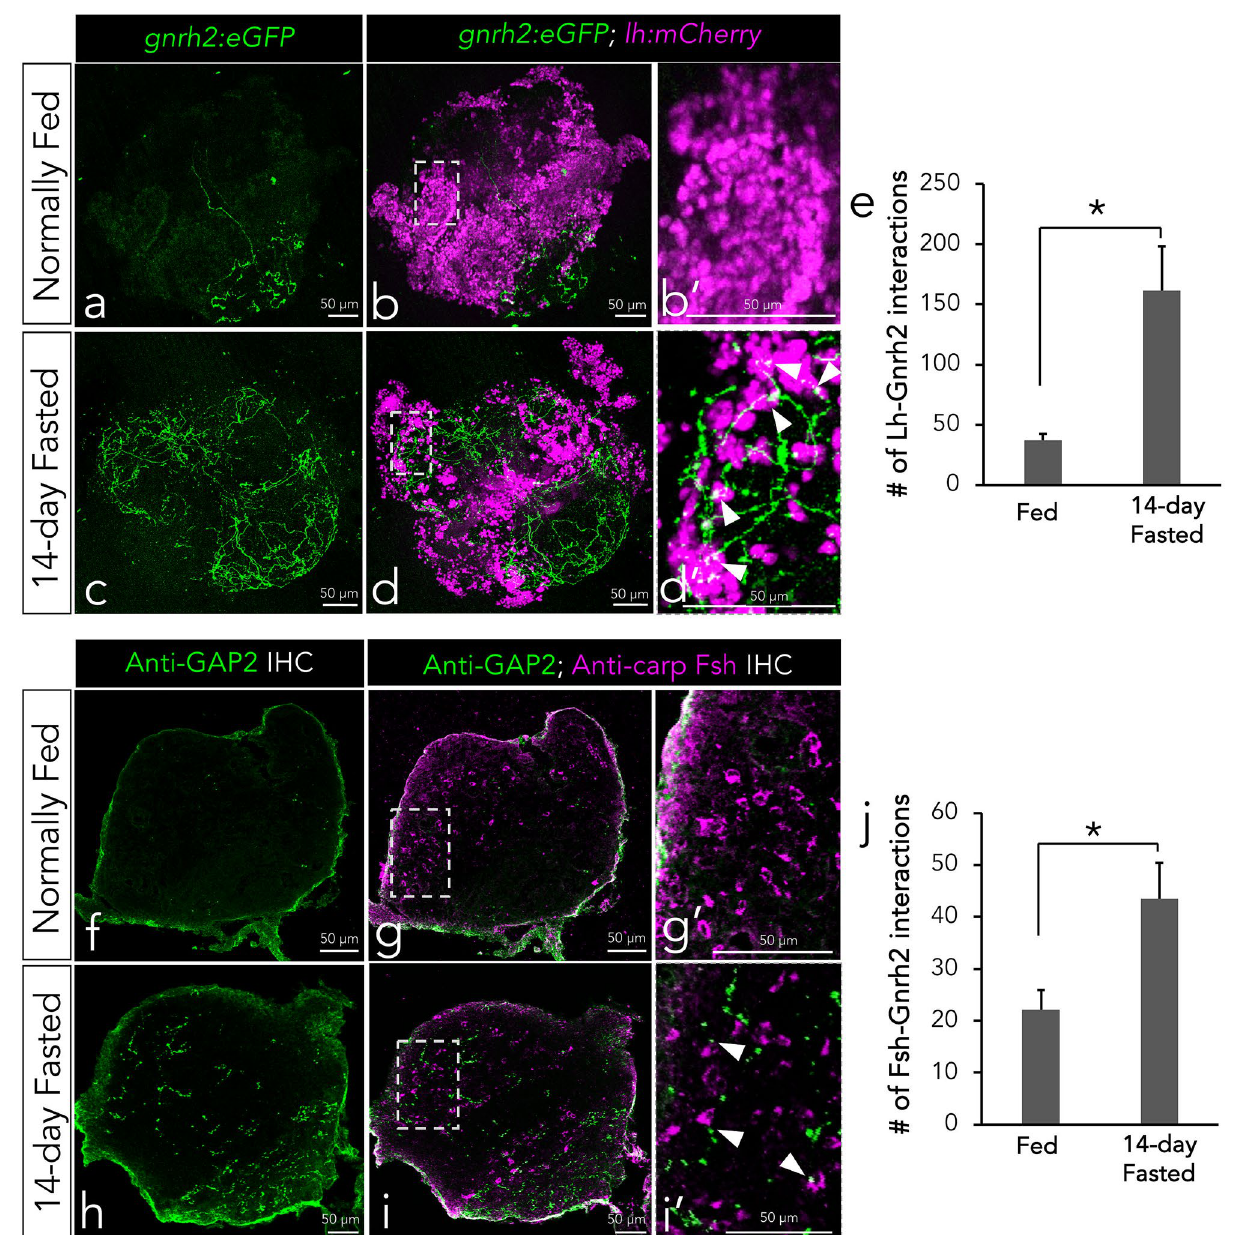
Figure 2. Confocal imagery of whole tg(gnrh2:eGFP;lh:mCherry) pituitaries in normally fed (a, b) and 14-day fasted zebrafish (c, d). B’ and d’ are magnifications of the boxed regions shown in b and d. Quantification of Lh cells with close Gnrh2 neuronal contact confirms increased interactions after 14-day fasting (E). Immunohistochemistry antibody staining of Gnrh2 and Fsh on pituitary cryosections of fish in normally fed (f, g) and 14-day fasted (h, i) conditions. G’ and i’ are magnifications of the squared regions shown in g and i. Quantification of Fsh cells with close Gnrh2 contact confirms increased interactions after 14-day fasting (j). ∆ indicate close contact of Gnrh2 neurons with gonadotropes. All data expressed as means ± S.E.M, n = 6 pituitaries per group, *P <